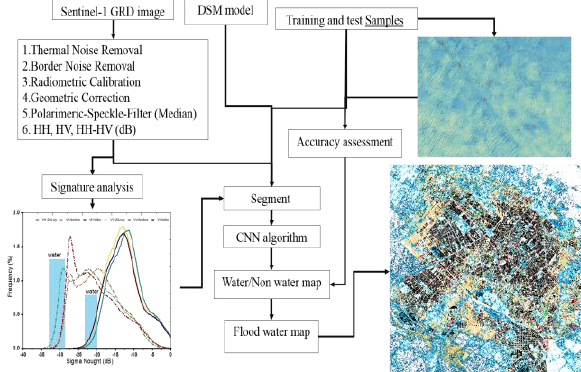
Figure 2. Schematic flowchart of the methodology adopted in this study to process the Digital Surface Model (DSM) and Sentinel-1 image in Convolutional Neural Network (CNN) algorithm .